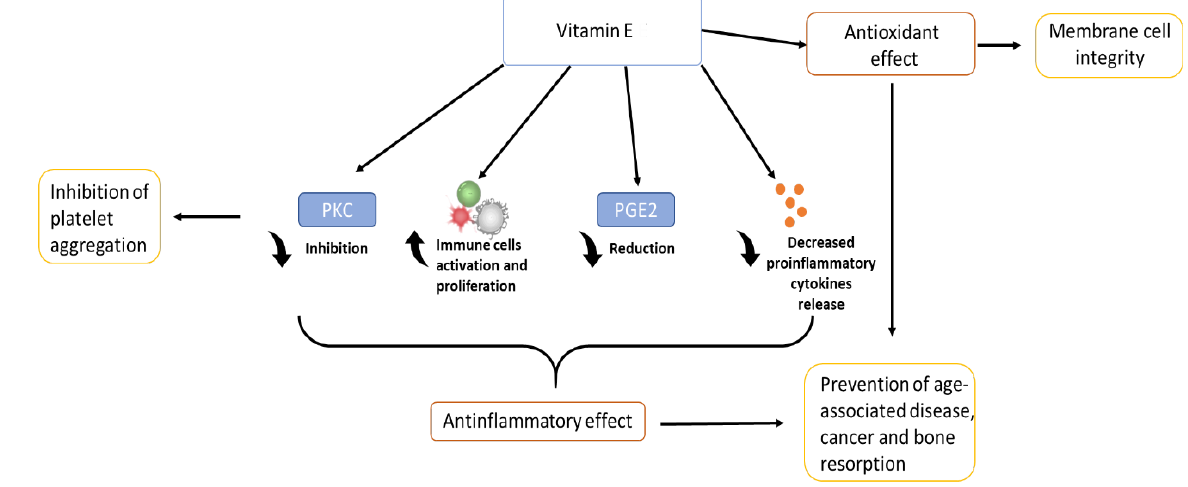
Figure 3. Biological role of vitamin E.